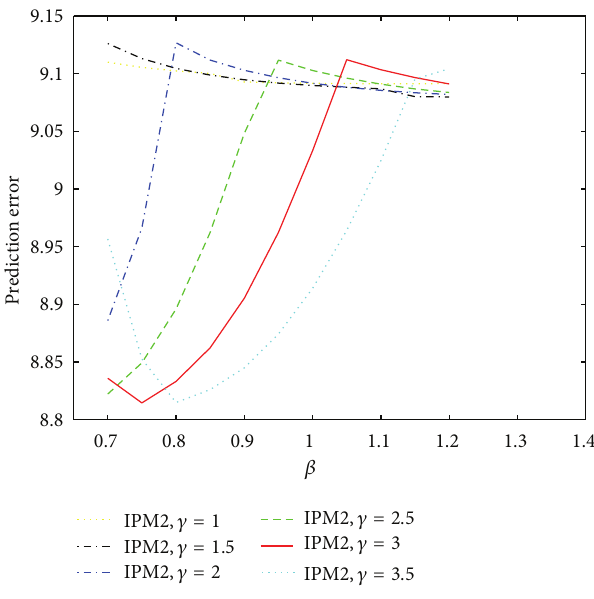
Figure 1: The prediction errors of the new improved parsimonious multivariate Markov chain model with our new convergence condi- tion of the new variability in Example